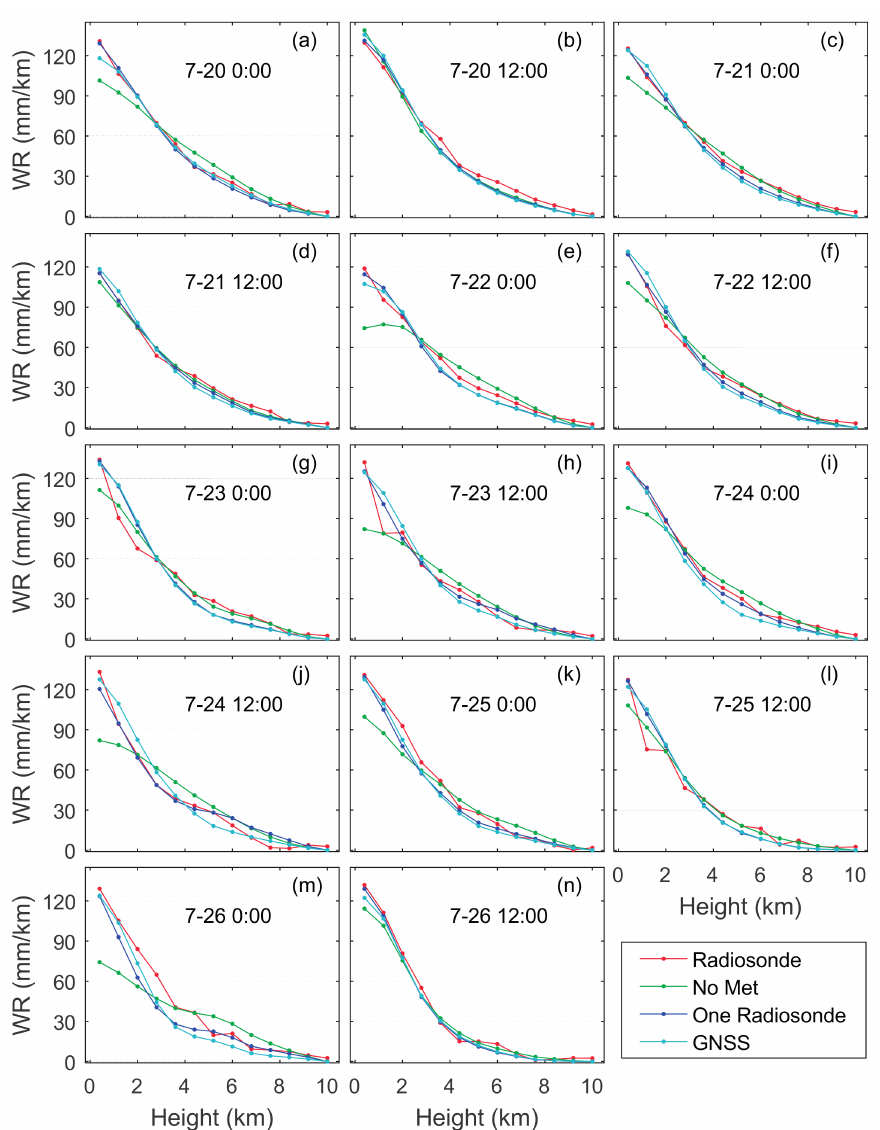
Figure 4. Comparisons between the tomography results and radiosonde results during 20 July to 26 July. Green lines indicate the a priori information free strategy; Blue lines indicate the one radiosonde constrained strategy; Cyan lines indicate the GNSS meteorological data constrained strategy. ( a – n ): comparisons between WR at different time